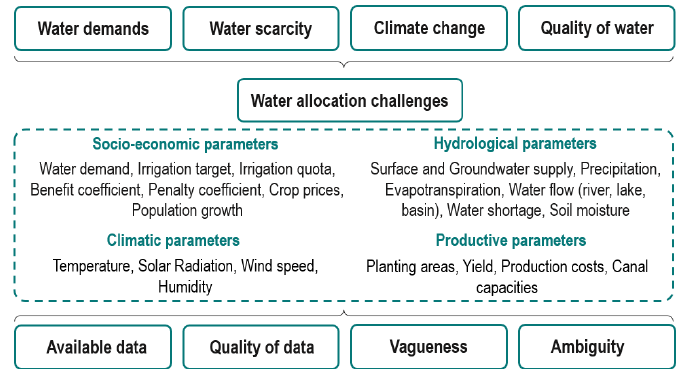
Figure 2. Agricultural water allocation challenges.